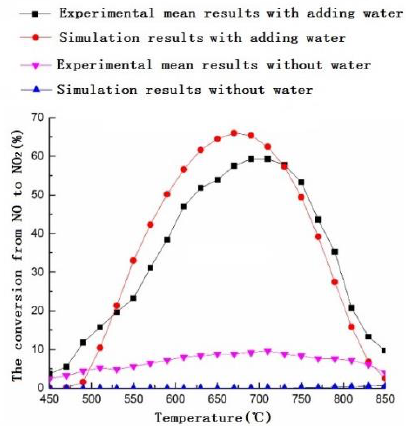
Figure 10. Effect of water vapor on the conversion.